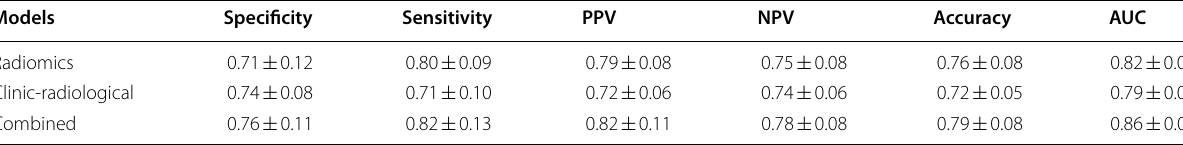
Values are mean ( standard deviation) over the cross-validation iterations ± PPV positive predictive value, NPV negative predictive value, AUC area under the curve